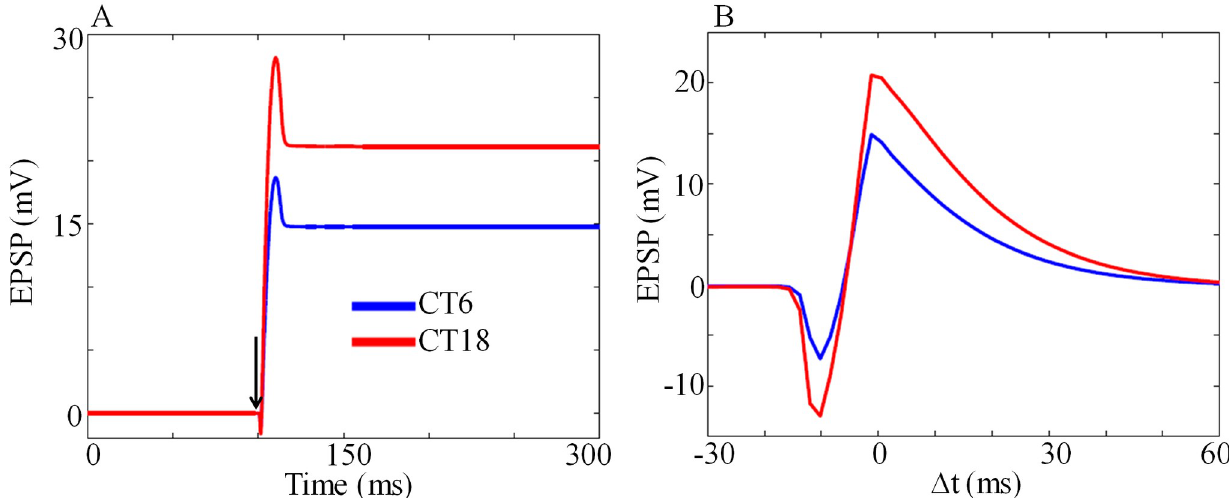
Fig 7. LTP at two different circadian times. (A) EPSP as a function of time at subjective day (CT6) and subjective night (CT18), where Δ t = 0. Larger LTP in simulation seen during subjective night is in good agreement with the experimental results [19]. Arrow head indicate the time at which I applied. (B) EPSP as a function of Δ t . The magnitude of the I pre and I post are 35 pA and 800 pA respectively, and the duration of the current is 2 ms